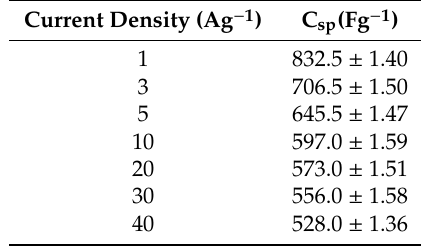
Table 5. C sp values with standard error of P-5PA against a wide range of current